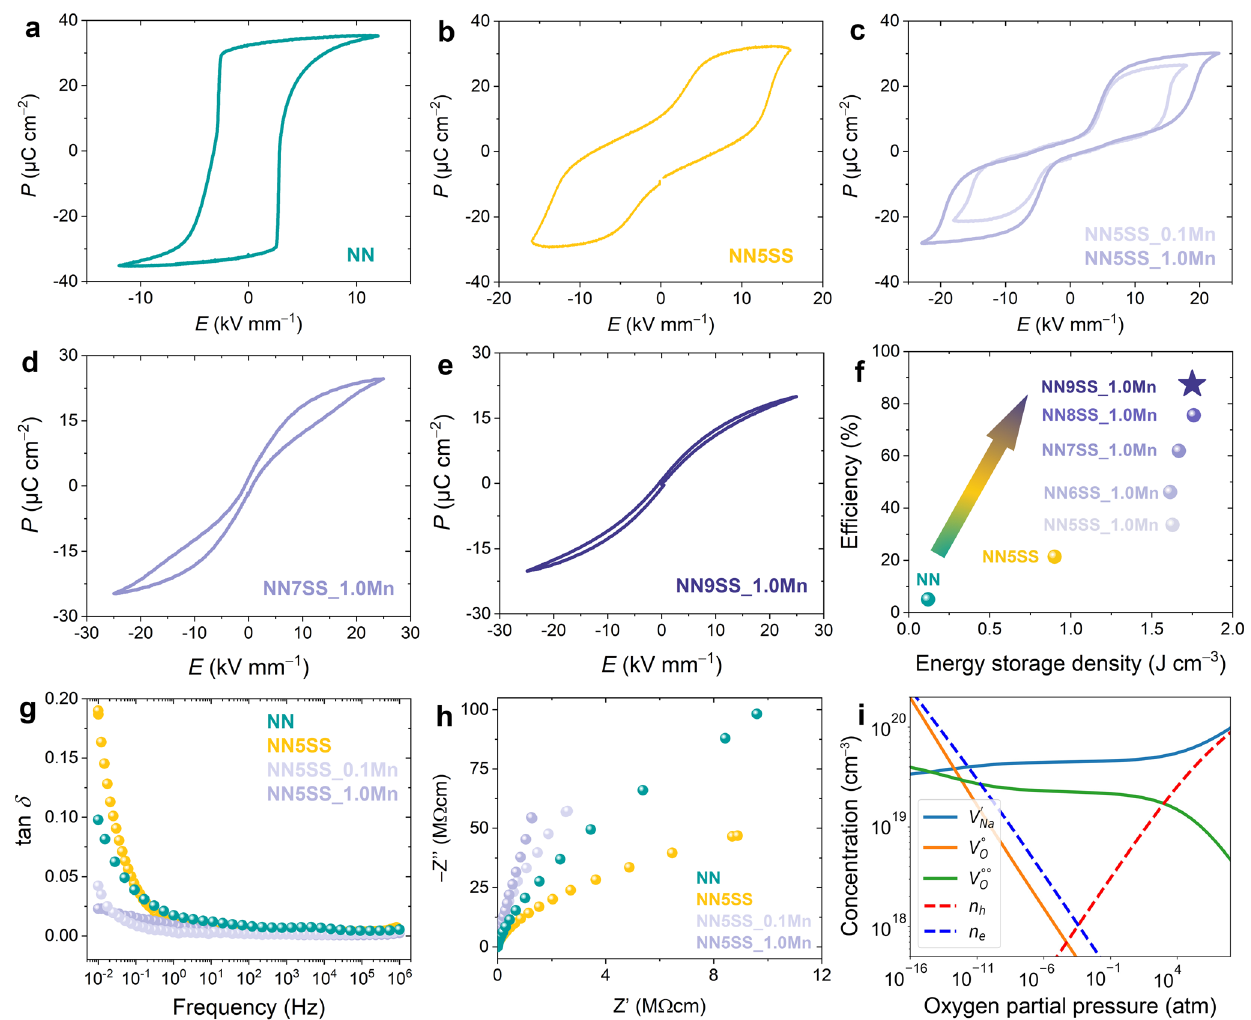
materials. g Frequency-dependent loss tangent and h Nyquist-plot of the NN, NN5SS, NN5SS_0.1Mn, and NN5SS_1.0Mn samples. i Concentrations of sodium vacancies ( V 0 Na ), oxygen vacancies ( V (cid:2)(cid:2) O and V (cid:2) O ), holes ( n h ), and electrons ( n e ) as a function of oxygen partial pressure, calculated at a temperature of